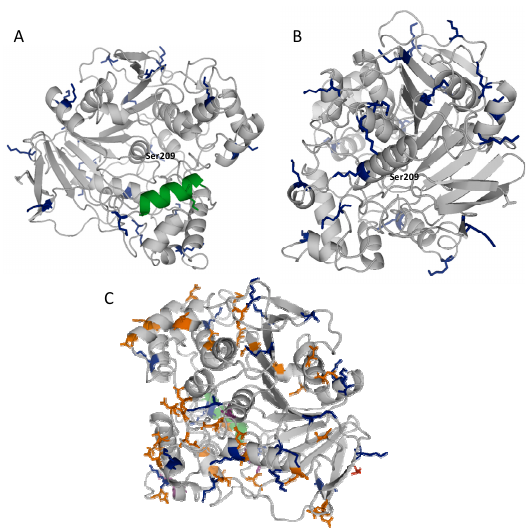
Figure 1. Structure of mature CRL. ( A ) Lid side. Oligopeptide lid (green), Lys (blue); ( B ) Lid opposite side marked lysines; ( C ) Lid opposite side marked lysines and aspartic and alutamic acids (orange). The structure of CRL was obtained from the Protein Data Bank (pdb code: CRL) and the picture was created using Pymol v. 0.99.